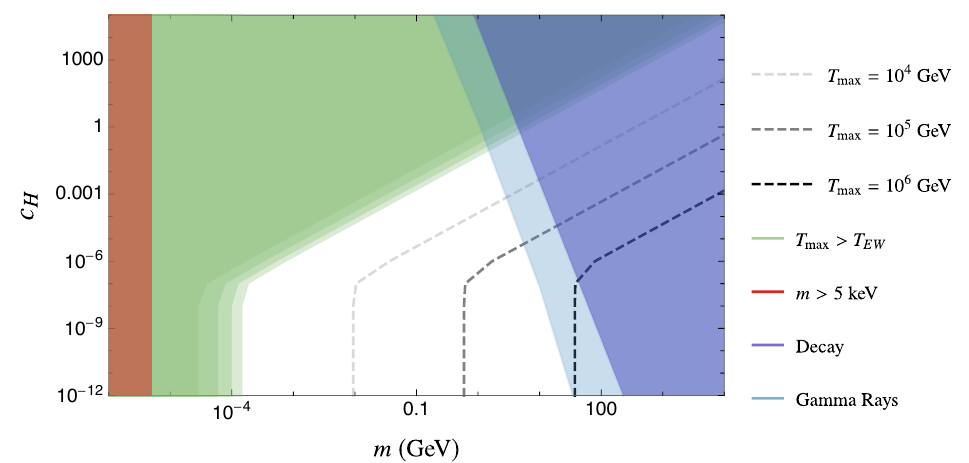
Figure 7: Spin-2 DM in the Higgs-mediated scenario. We show the contours of constant T leading to the correct freeze-in relic abundance. The light blue regions max are excluded by the model-independent bound on the DM lifetime [ 52 ] and gamma- ray constraints [ 53 ] . The red region is excluded by the lower mass limit from small- scale structure, while in the green region ensures T is below the electroweak max